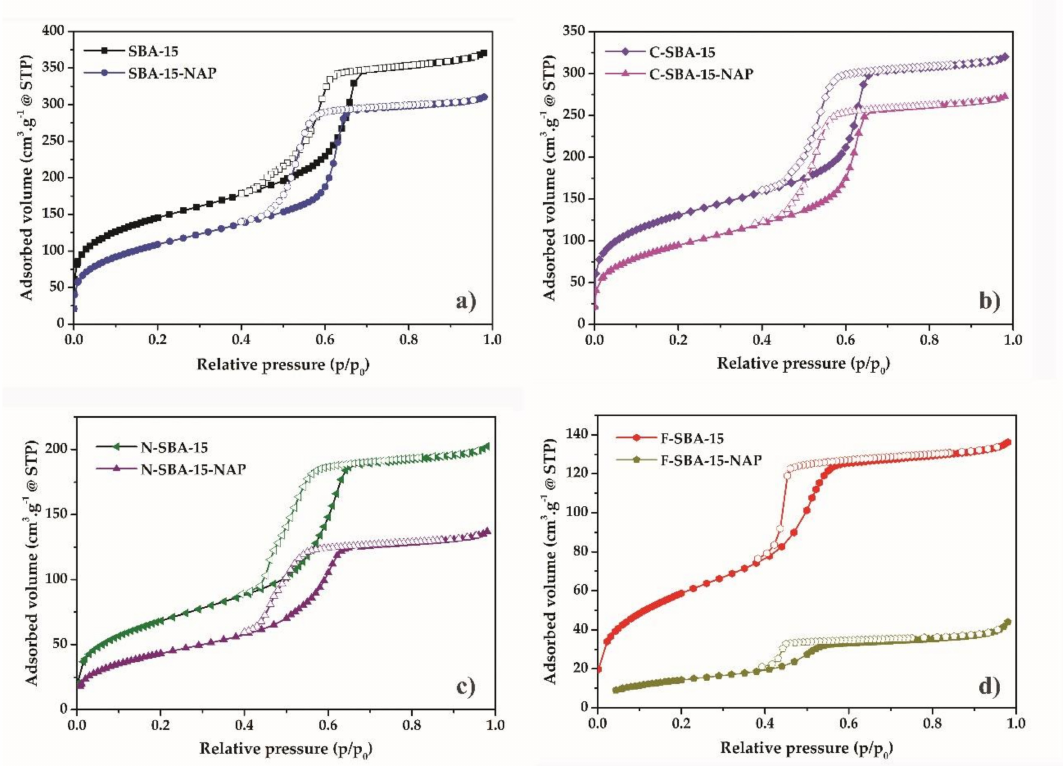
Figure 2. Nitrogen adsorption / desorption isotherms at 77 K for the materials ( a ) SBA-15 and SBA-15-NAP, ( b ) C-SBA-15 and C-SBA-15-NAP, ( c ) N-SBA-15 and N-SBA-15-NAP, ( d ) F-SBA-15 and